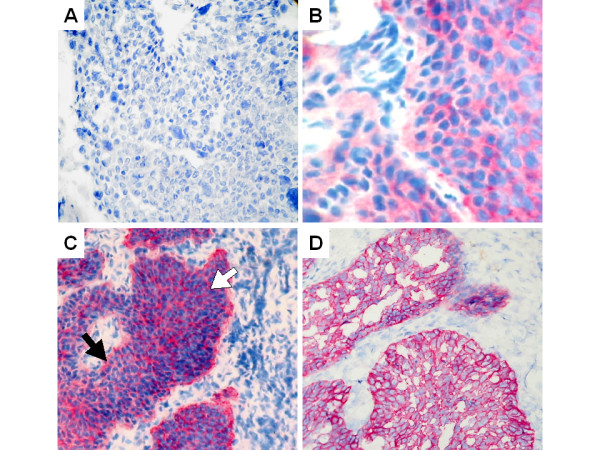
Ep-CAM expression in esophageal SCC. A, esophageal SCC without Ep-CAM neo-expression. B, Detail of a tumor with 2+ Ep-CAM expression. C, Tumor with heterogeneous 3+ Ep-CAM expression (white arrow: strong expression; black arrow: faint expression) and D, shows a representative sample with homogenous 3+ Ep-CAM expression.